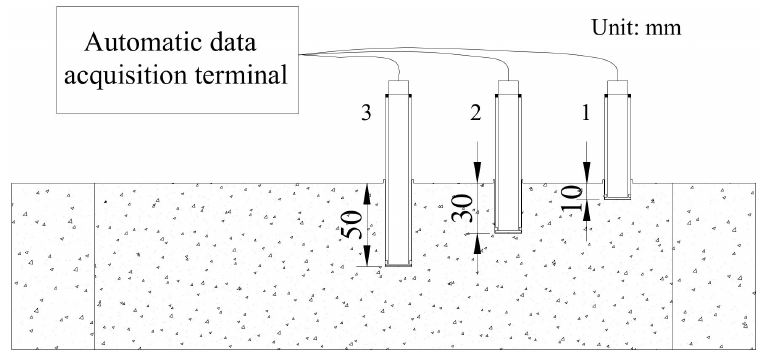
Figure 3. Sensor embedding